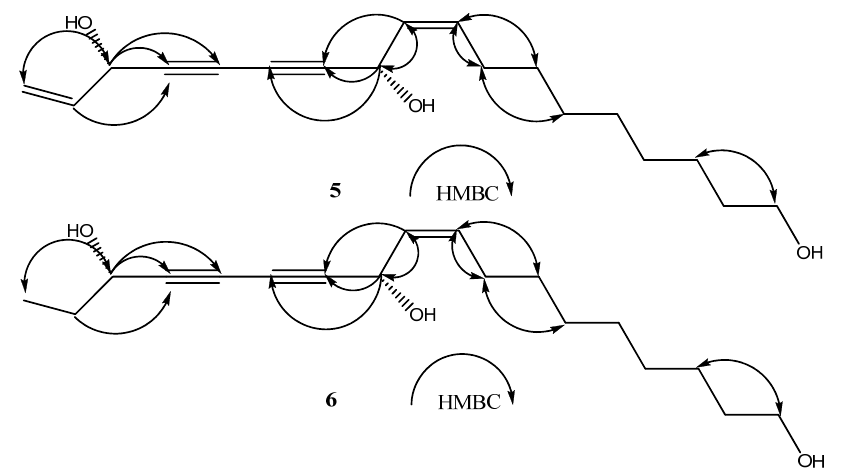
Figure 2. Key HMBC correlations (H → C) of compounds 5 and 6